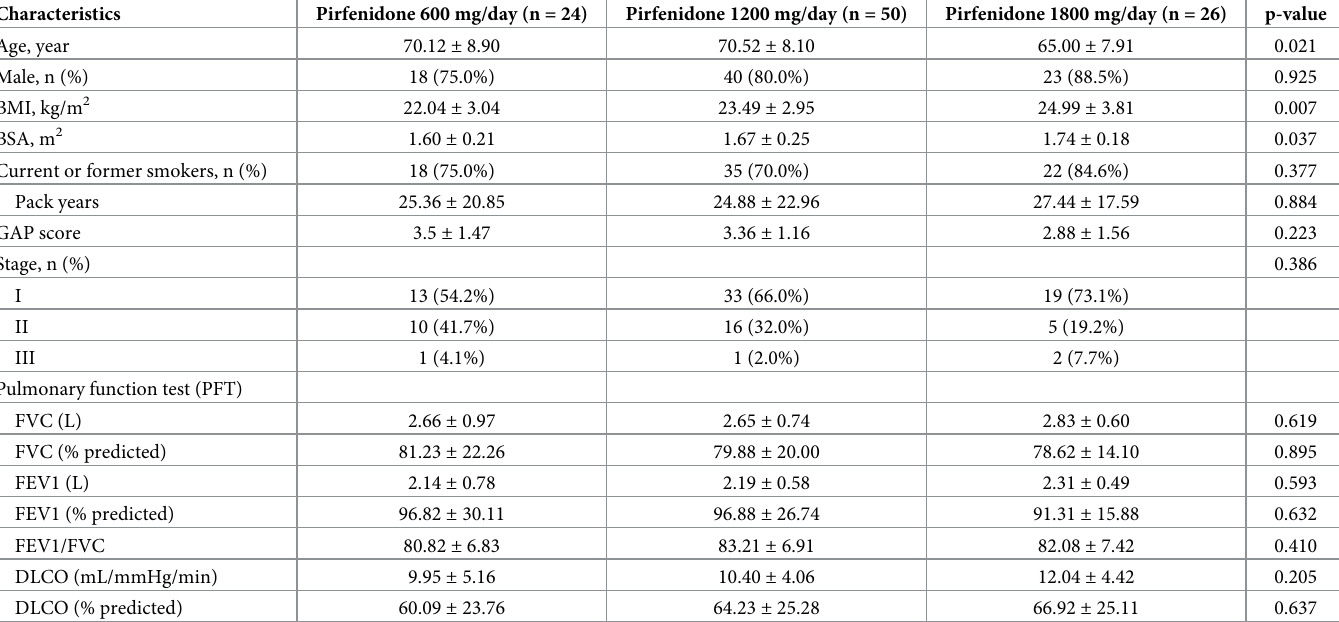
Table 2. Baseline epidemiological and clinical characteristics according to dose in patients treated with pirfenidone (n = 100).